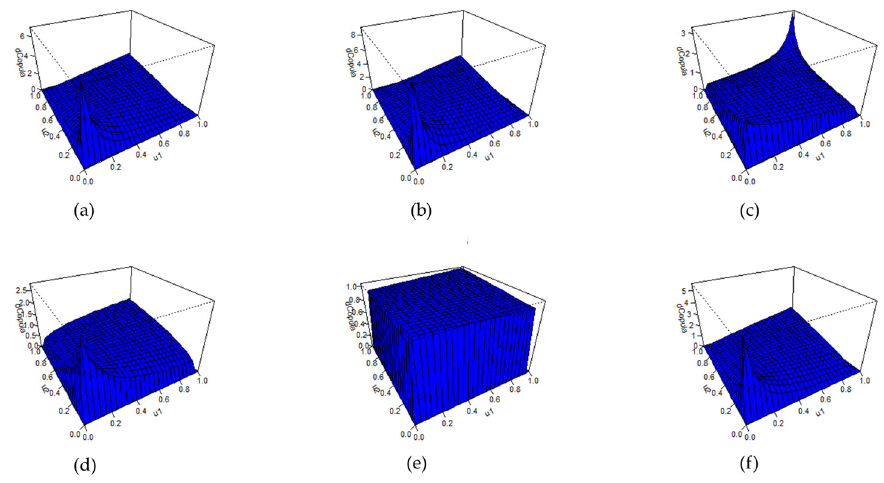
Figure 16. Plot of joint density function in Cluster Type II.